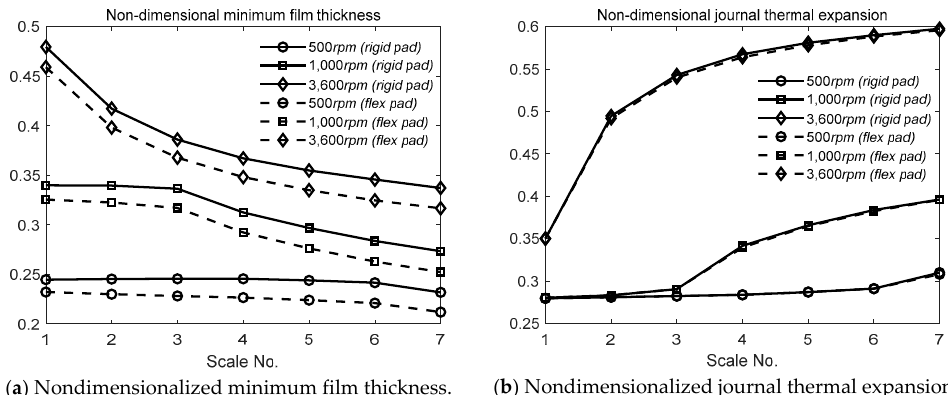
Figure 9. Nondimensionalized thermal deformation properties.